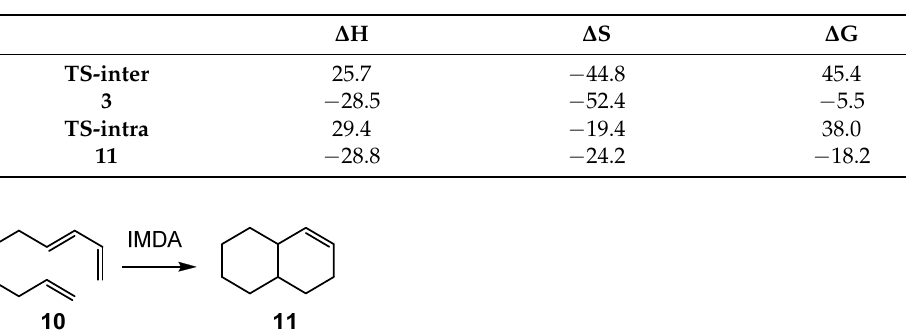
Table 1. B3LYP/6-311G(d,p) relative enthalpies ( ∆ H, in kcal · mol − 1 ), entropies ( ∆ S, in cal · mol − 1 · K) and Gibbs free energies ( ∆ G, in kcal · mol − 1 ) computed at 165 ◦ C and 1 atm of the stationary points involved in the intermolecular N-DA reaction of butadiene 1 and ethylene 2 , and in the IMDA reaction of ( E )-deca-1,3,9-triene 10 .